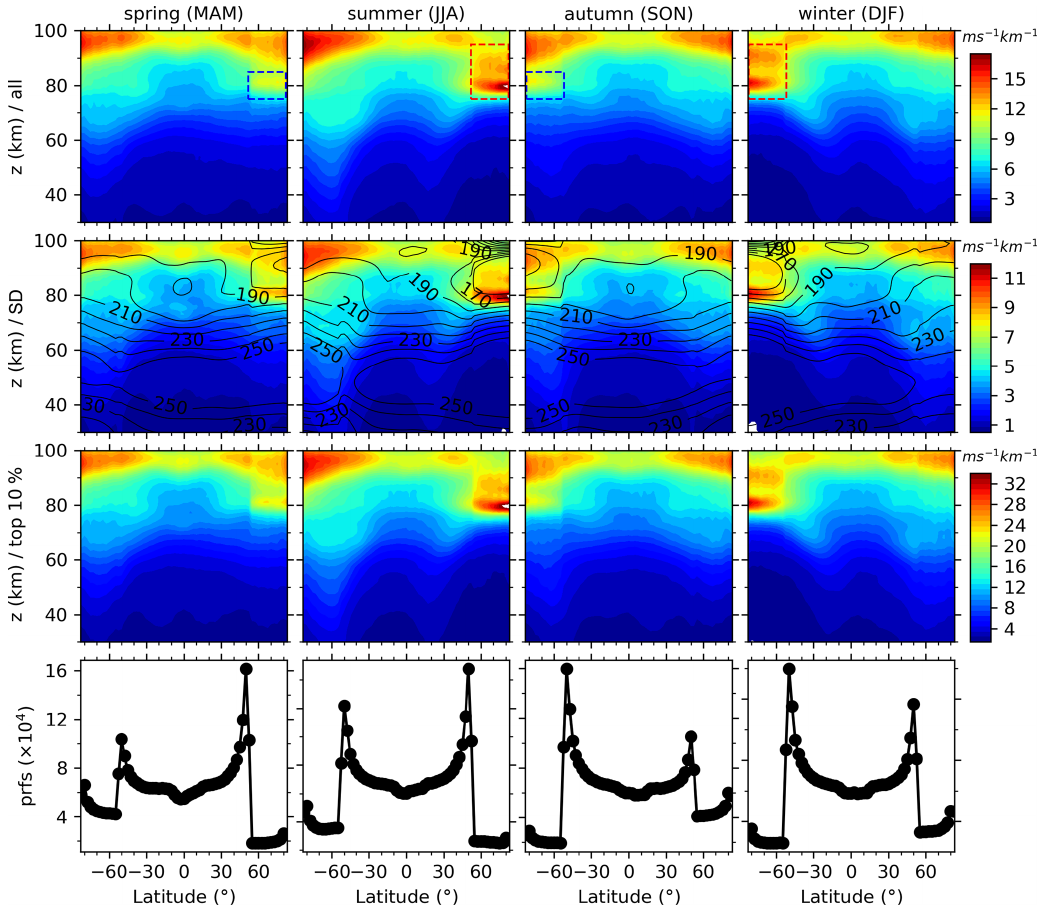
Figure 6. Latitude–height contours of the zonal means (the first row) and standard deviations (SDs, the second row) of GW-perturbed wind shears and the top 10% largest shears (the third row) during four composite seasons (noted on the top of each column). The composite season is the superposition of the corresponding season from 2002 to 2019. For more readability, the zonal-mean temperatures are shown as contour lines only in the second row. The rectangles are to highlight the peak at a lower height. The numbers of profiles used to derive GW-perturbed wind shears in each season are shown in the fourth row. Same color scale is used in each row with units of ms − 1 km − 1 . Each row has the same y -axis scale. All panels have the same x -axis